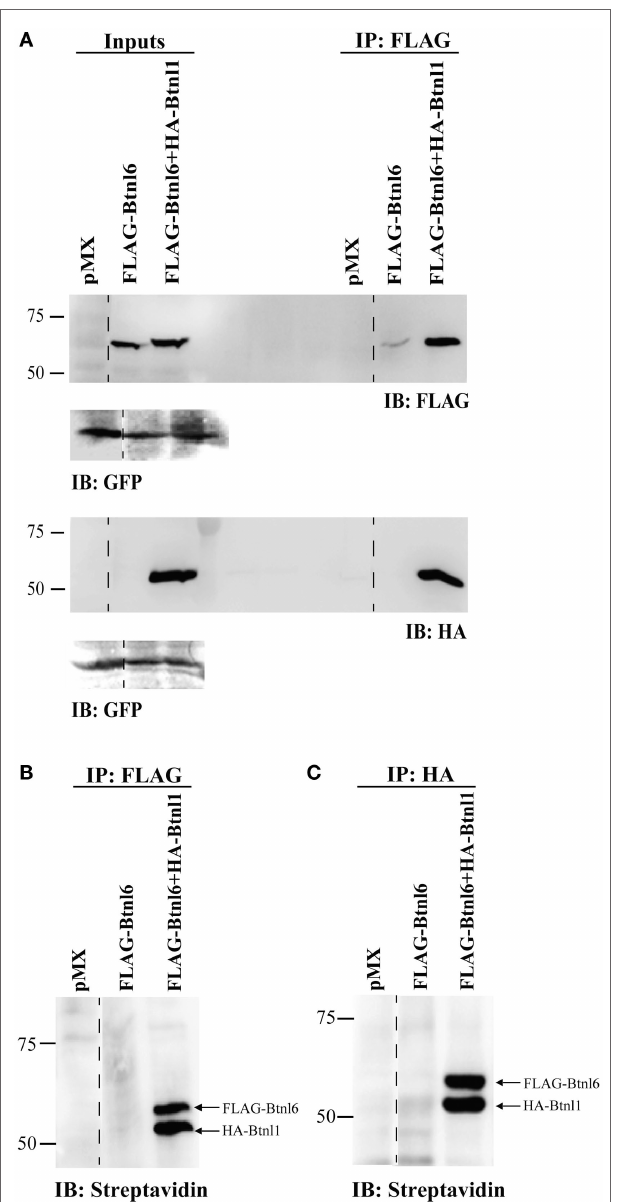
FigUre 3 | Btnl6 forms plasma membrane-tethered heteromeric complexes with Btnl1 in small intestinal epithelial cells. MODE-K cells were transfected with FLAG-tagged Btnl6 cDNA pMX-IRES-GFP, FLAG- tagged Btnl6 cDNA- and HA-tagged Btnl1 cDNA pMX-IRES-GFP, or empty vector (pMX-IRES-GFP). Cell surface proteins were biotinylated prior to cell lysis, and coimmunoprecipitated using FLAG or HA tags. Biotinylated material, immunoprecipitated with anti-FLAG or anti-HA, was either immunoblotted using anti-FLAG or anti-HA (a) , or detected with streptavidin- HRP (B,c) . GFP immunoblot acts as a loading control. The lanes were reorganized (dashed lines) from the same gel without any image manipulation. Data are representative of two